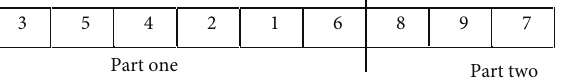
Figure 4: Chromosome